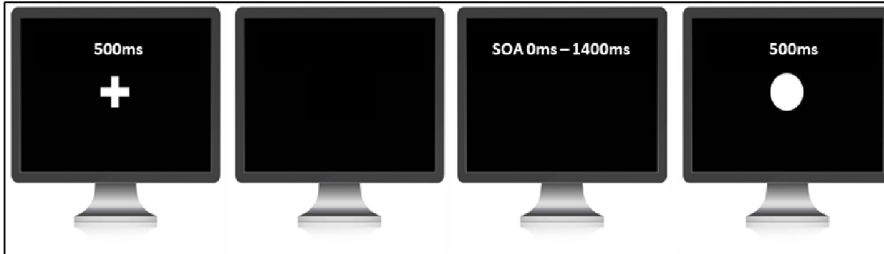
Fig 1. Paradigm of the judgement of agency task.